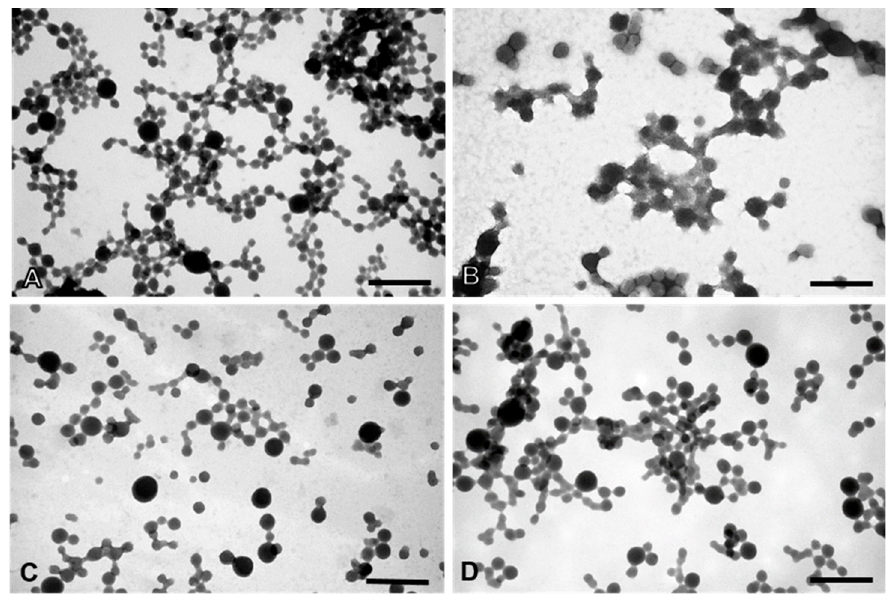
Figure 12. TEM images of BSA NPs. ( A ) empty ERL conjugated NPs; ( B ) PvD-loaded non-conjugated NPs; ( C ) ERL conjugated NPs PvD-loaded; ( D ) empty non-conjugated NPs. Scale bars = 0.5 µ m.